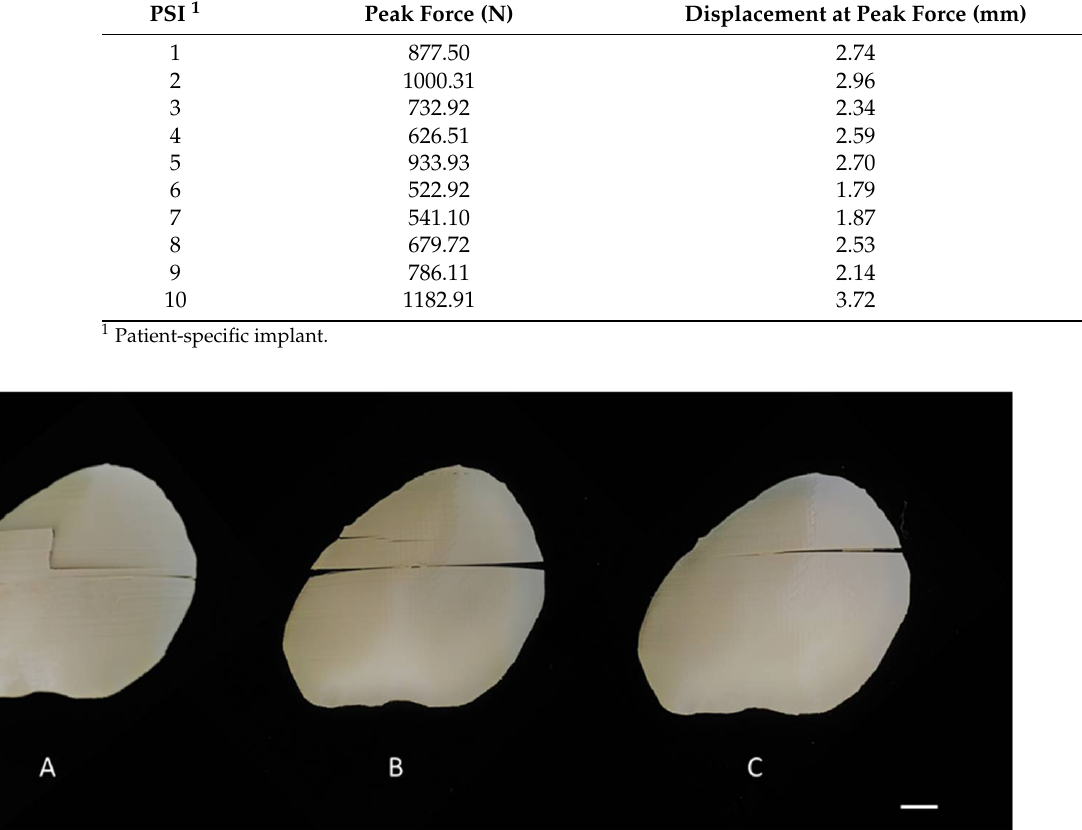
6 of 19 Table 3. Peak force (N) vs. displacement at peak force (mm) in material extrusion 3D-printed PEEK patient-specific cranial implants. PSI 1